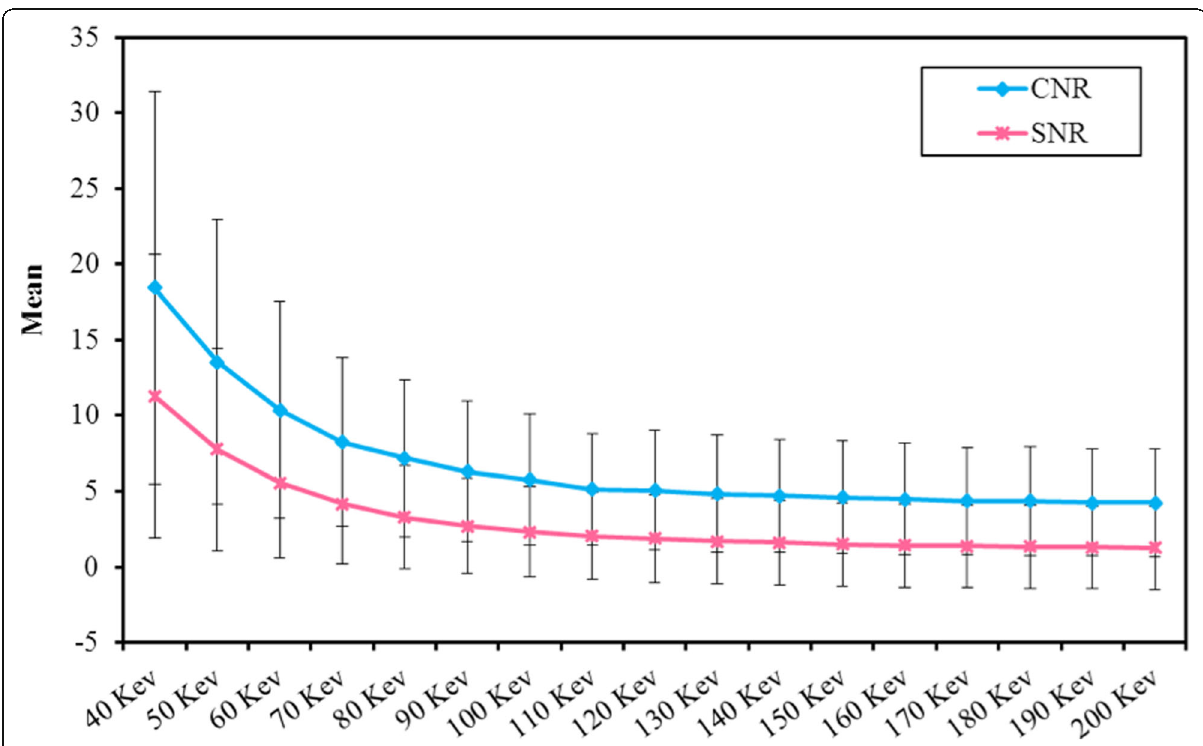
Fig. 1 CNR and SNR across the range of VME images (40 – 200